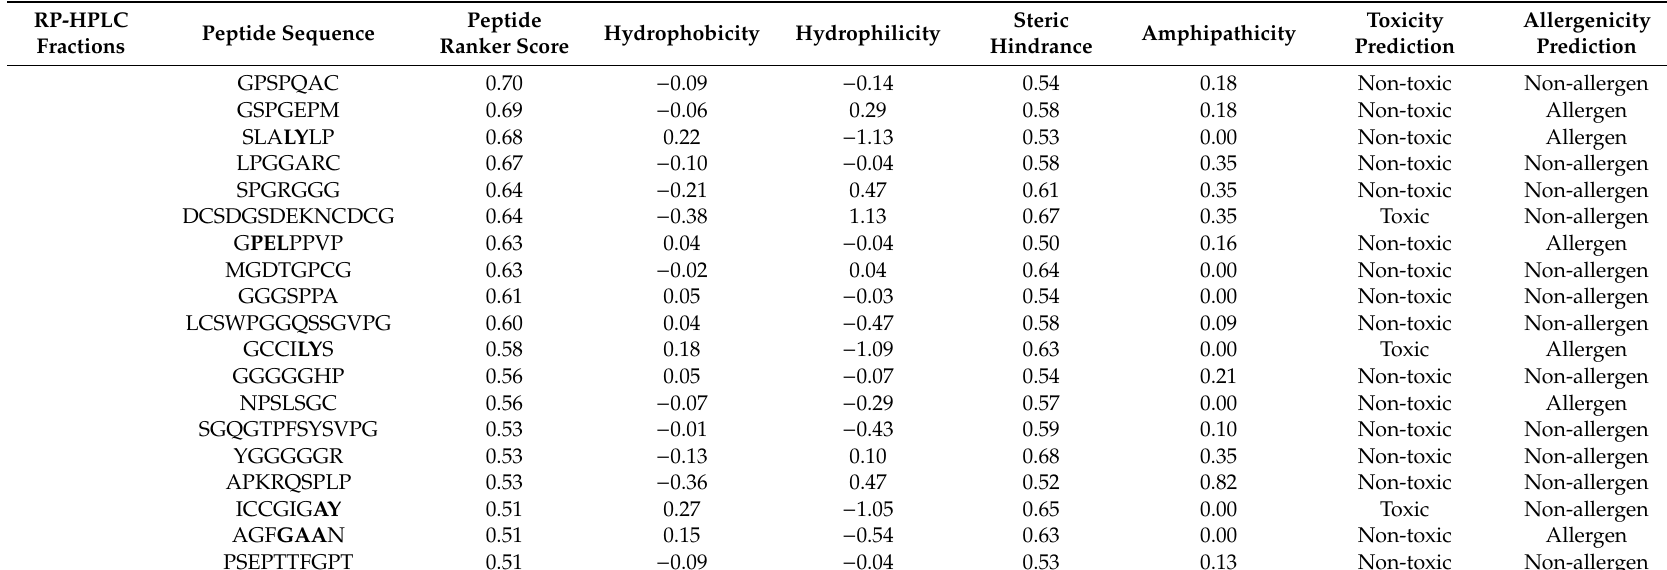
Bold letters indicate active domains previously reported as antioxidant sequences according to BIOPEP